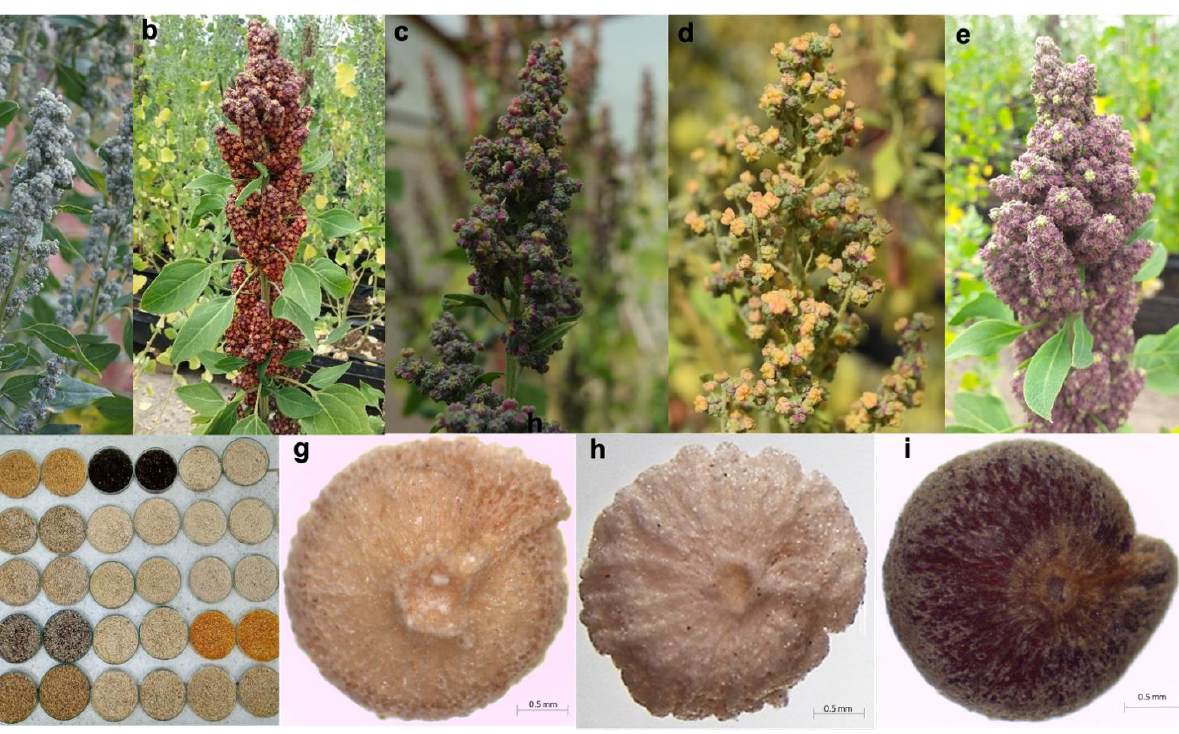
Figure 5. Multiple correspondence analysis showing the contribution of variables, ordering the accessions according to the qualitative variables.